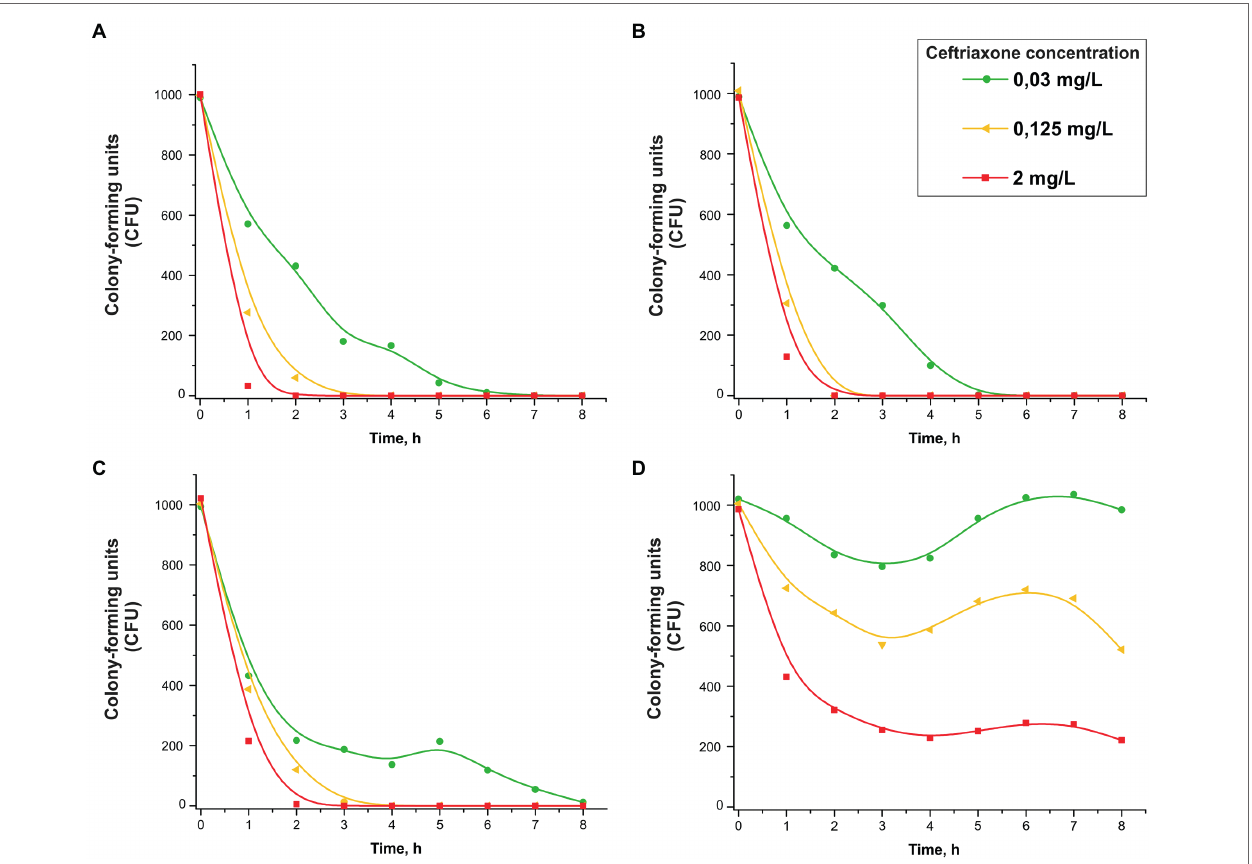
FIGURE 3 | Change in the CFU number vs. time in the presence of 0.03, 0.125, or 2 mg/L ceftriaxone for Neisseria gonorrhoeae strain ATCC 49226 not carrying plasmids (A) , carrying p bla TEM-1 (B) , carrying p bla TEM-135 (C) , and carrying p bla TEM-20 ( D ; 37 ° C, 5% CO 2 ). The dots correspond to the mean CFU from three independent experiments (the initial CFU and the standard deviations are provided in Supplementary Table S2